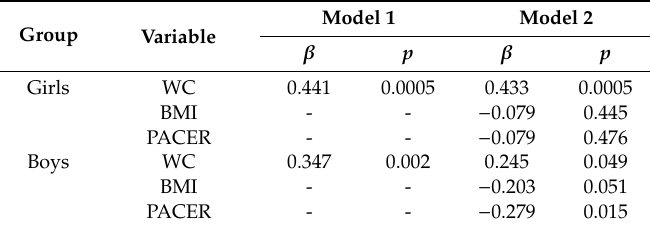
Table 5. Relationship between fitness and fatness in a generalized linear model of